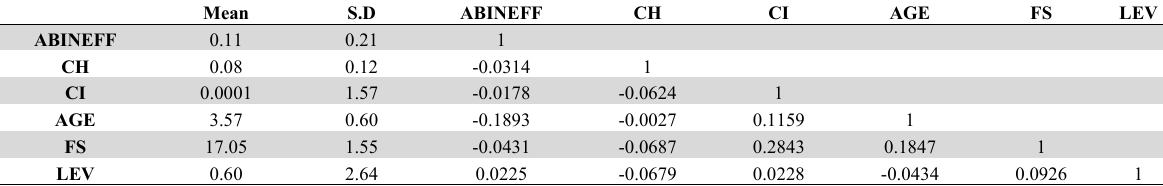
Table 2 Descriptive Statistics and Correlation Analysis (India